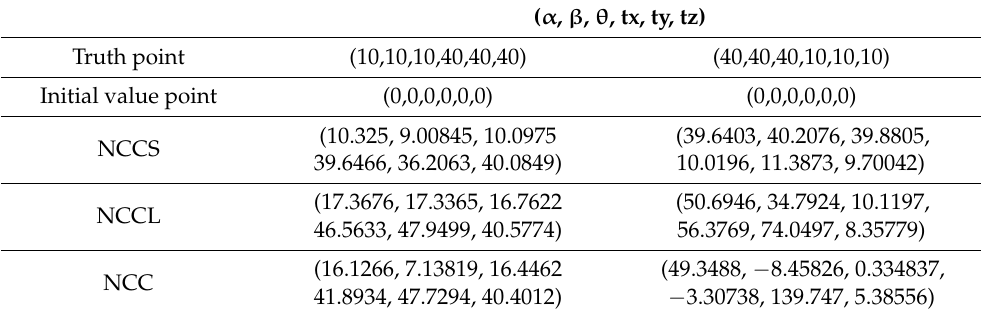
Table 3. Experimental results of single resolution with enlarged sampling